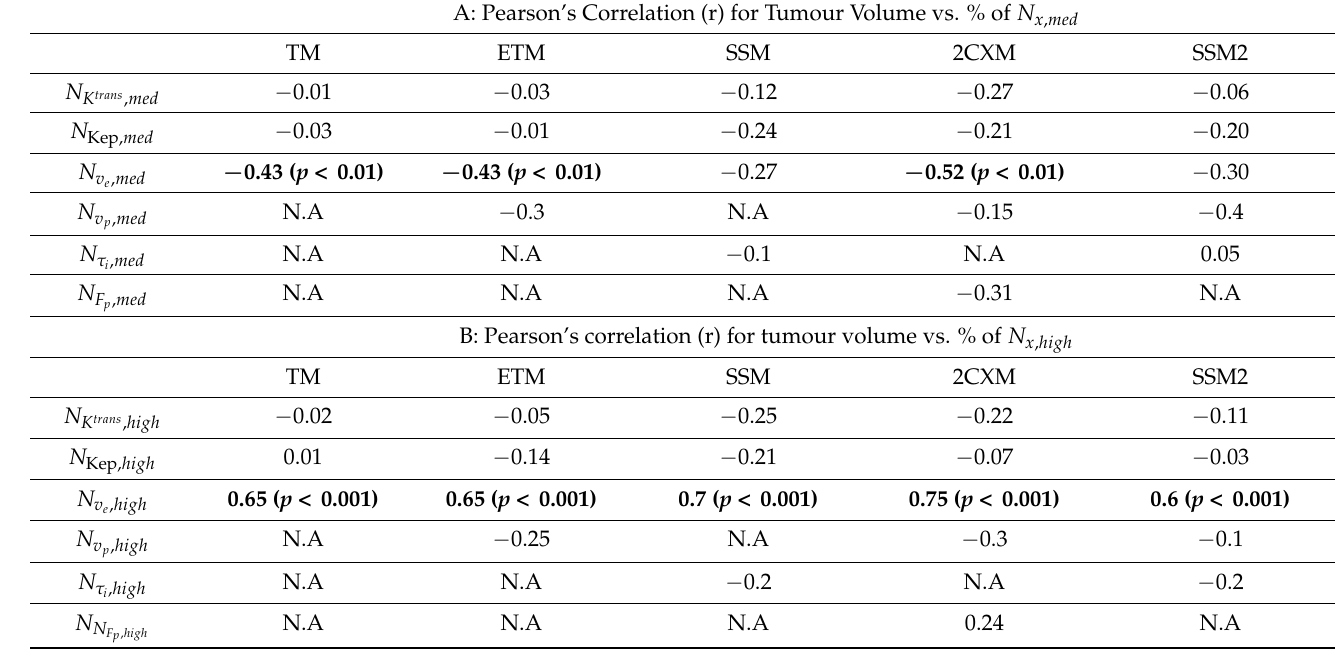
Table 2. Pearson’s correlation ( r ) for tumour volume vs. N x , med (A), and Pearson’s correlation ( r ) for tumour volume vs. N x , high